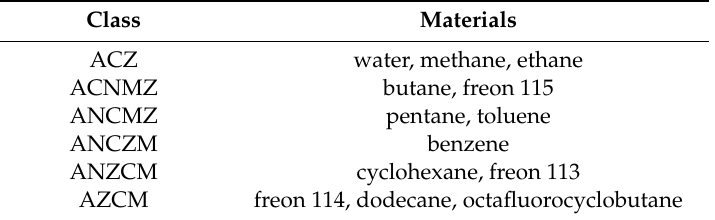
Table 1. Some real examples for various working fluid classes, for more examples, see reference